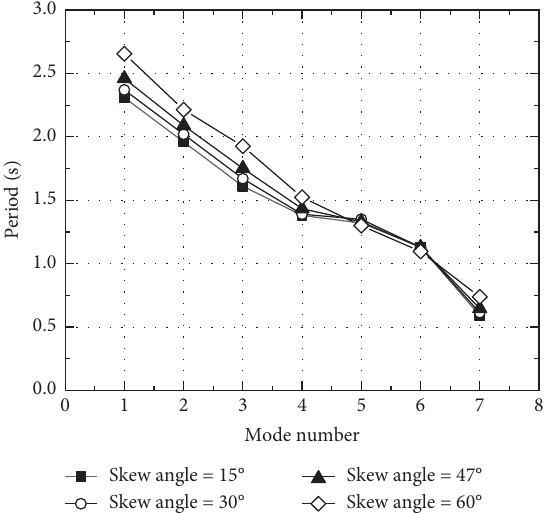
Figure 15: Comparison of modal periods with different skew